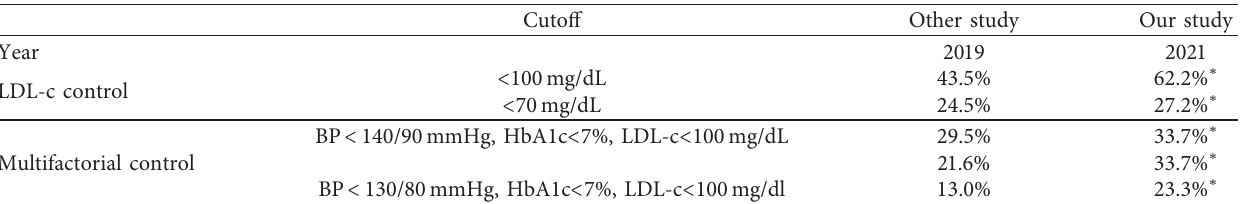
Table 4: Comparison of LDL-c and simultaneous control between our study and present-time trials according to different sets of criteria